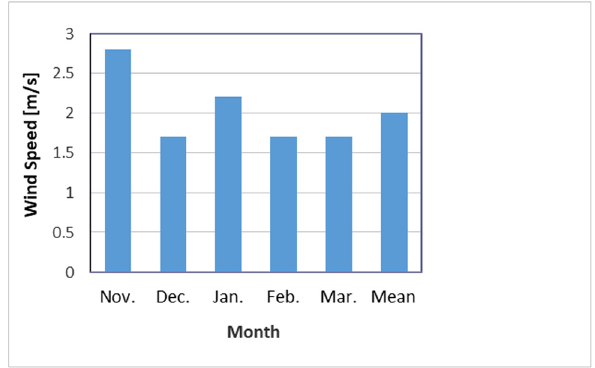
Figure 11: Monthly values and overall mean of wind speed during the study